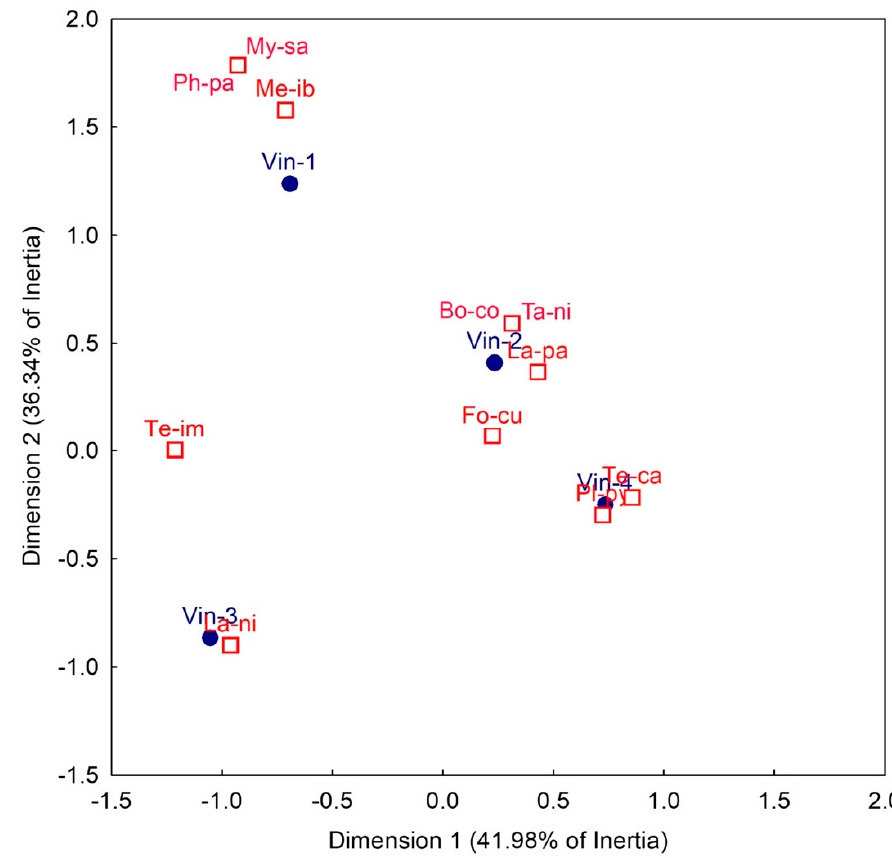
Figure 3. Biplot of the two first axes of the Correspondence Analysis relating ant species (represented by open red squares) and vineyards (represented by blue circles). Ant species: My-sa = Myrmica sabuleti ; Ph-pa = Pheidole pallidula ; Me-ib = Messor ibericus ; Bo-co = Bothriomyrmex communistus ; Ta-ni = Tapinoma nigerrimum ; La-pa = Lasius paralienus ; Fo-cu = Formica cunicularia ; Te-im = Tetramorium immigrans ; Te-ca = Tetramorium cfr. caespitum ; Pl-py = Plagiolepis pygmaea ; La-ni = Lasius niger . Vineyards: Vin-1 = vineyard 1; Vin-2 = vineyard 2; Vin-3 = vineyard 3; Vin-4 = vineyard 4.